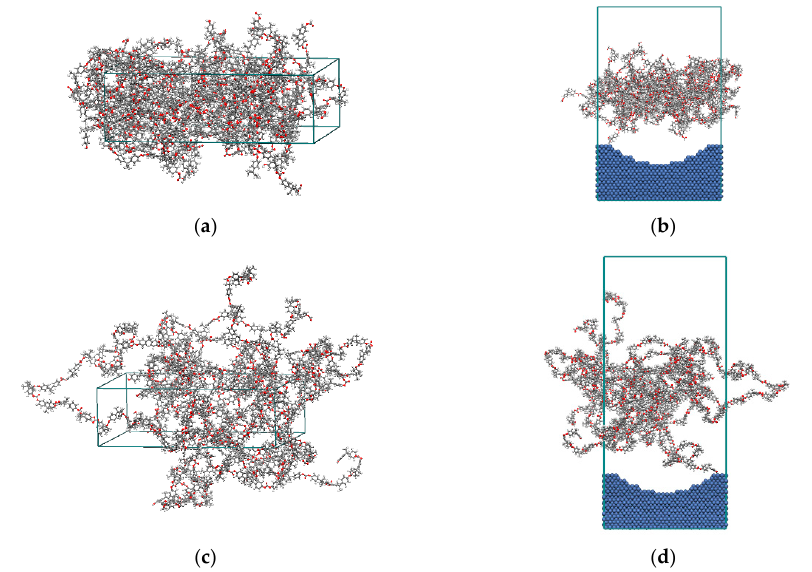
Figure 1. Simulation models. The blue lines indicate the simulation cell. ( a ) Short-chain polycarbonate (PC) model; ( b ) interface model between short-chain polymer and nickel mold insert; ( c ) long-chain PC model; and ( d ) interface model between long-chain polymer and nickel mold insert.